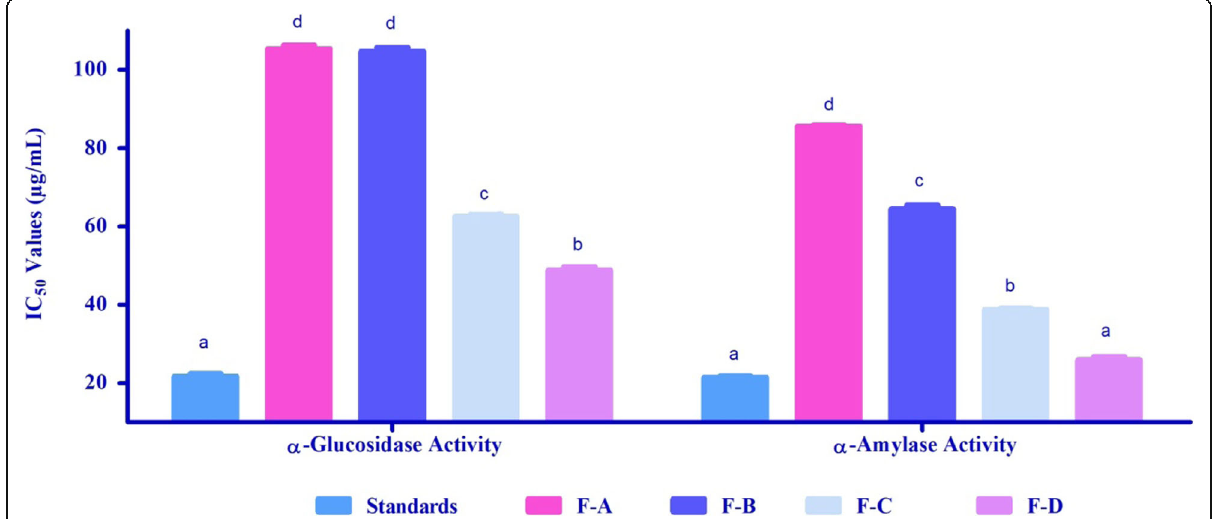
Fig. 8 IC 50 values of α -glucosidase and α -amylase inhibition activities of four pooled fractions of MeCV and acarbose standard. Each vertical bar represents mean ± SE for n = 3. The vertical bars having the same alphabet do not differ significantly, whereas the bars having the different alphabet differ significantly at P < 0.05 (one-way ANOVA followed by Tukey ’ s post hoc